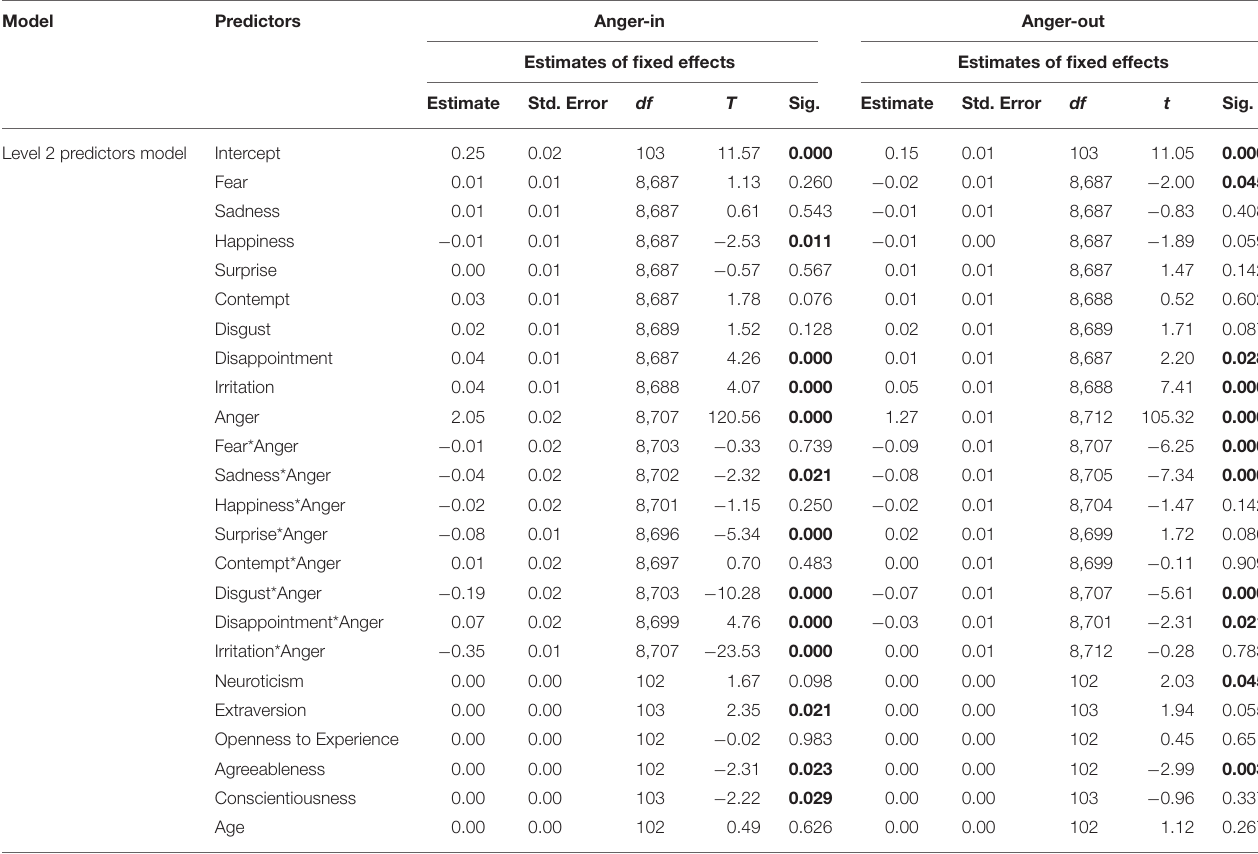
TABLE 2 | The estimates of the Level 2 fixed effects model of anger-in and anger-out behaviors.